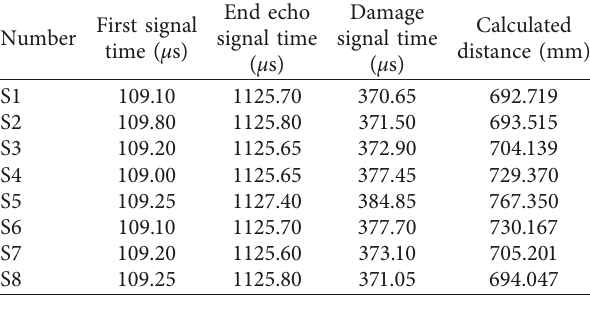
Table 7: Propagation distances between the reflection point and the signal receiving point.